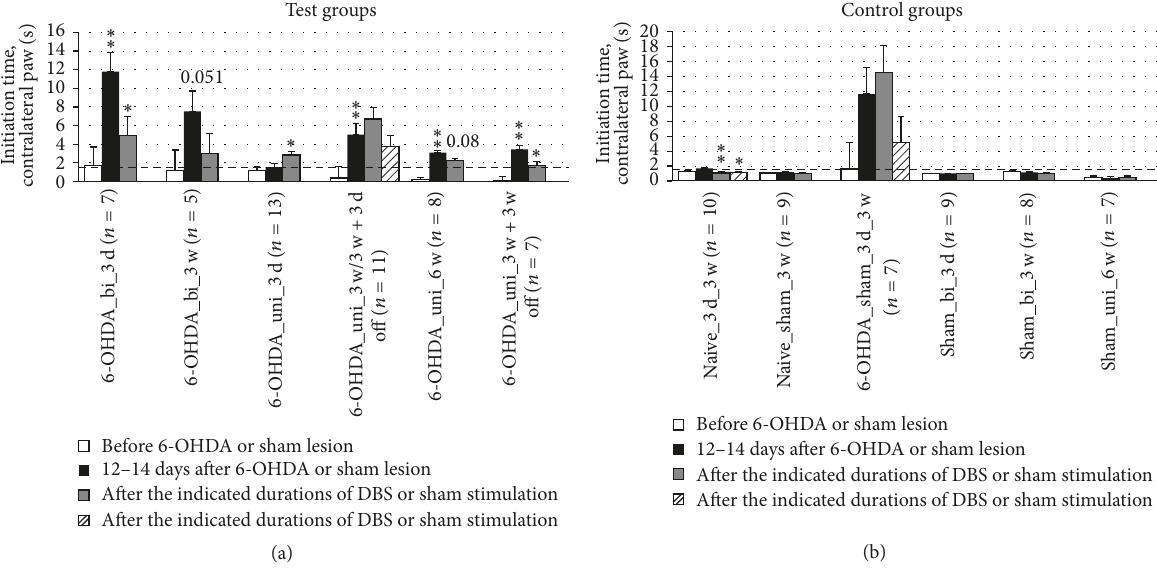
Figure 6: Short-term and long-term effects of DBS with uni- and bipolar electrodes on akinesia as measured by the initiation time of the first adjusting step of the contralateral forepaw in the stepping test. (a) and (b) refer to test groups and controls, respectively. The dashed line at 1s allows for an easier comparison with Figure 7 and between (a) and (b). Different column patterns indicate different times of behavioral testing; white: before 6-OHDA or sham lesion; black: 12–14 days after 6-OHDA or sham lesion; gray and hatched: after the durations of DBS or sham stimulation indicated in the group labels. For experimental details see Table 1. Significance levels are indicated with asterisks as follows: ∗∗ 𝑝 ≤ 0.01 , ∗ 𝑝 ≤ 0.05 , b (borderline): 0.05 < 𝑝 ≤ 0.08 according to one-way ANOVA. Asterisks above black columns refer to white columns; all others refer to black columns.